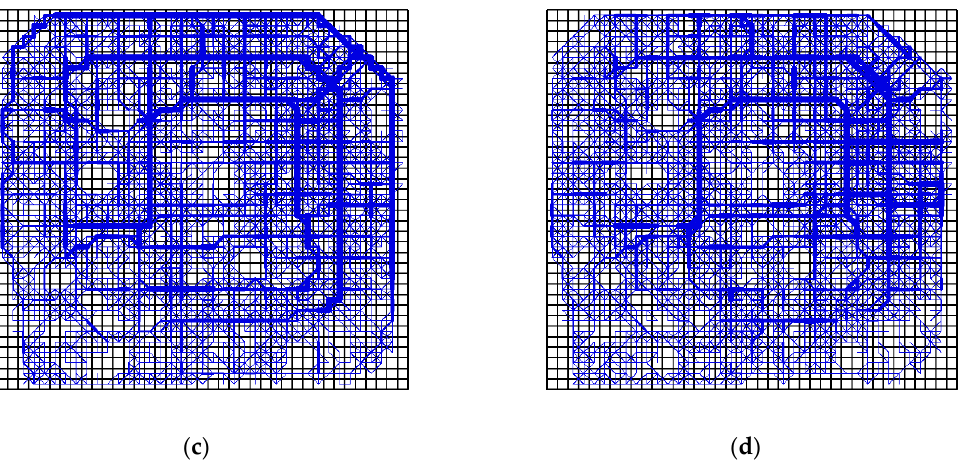
Figure 9. Spatially embedded networks for traffic flows in different time periods with cell size k = 500 m: